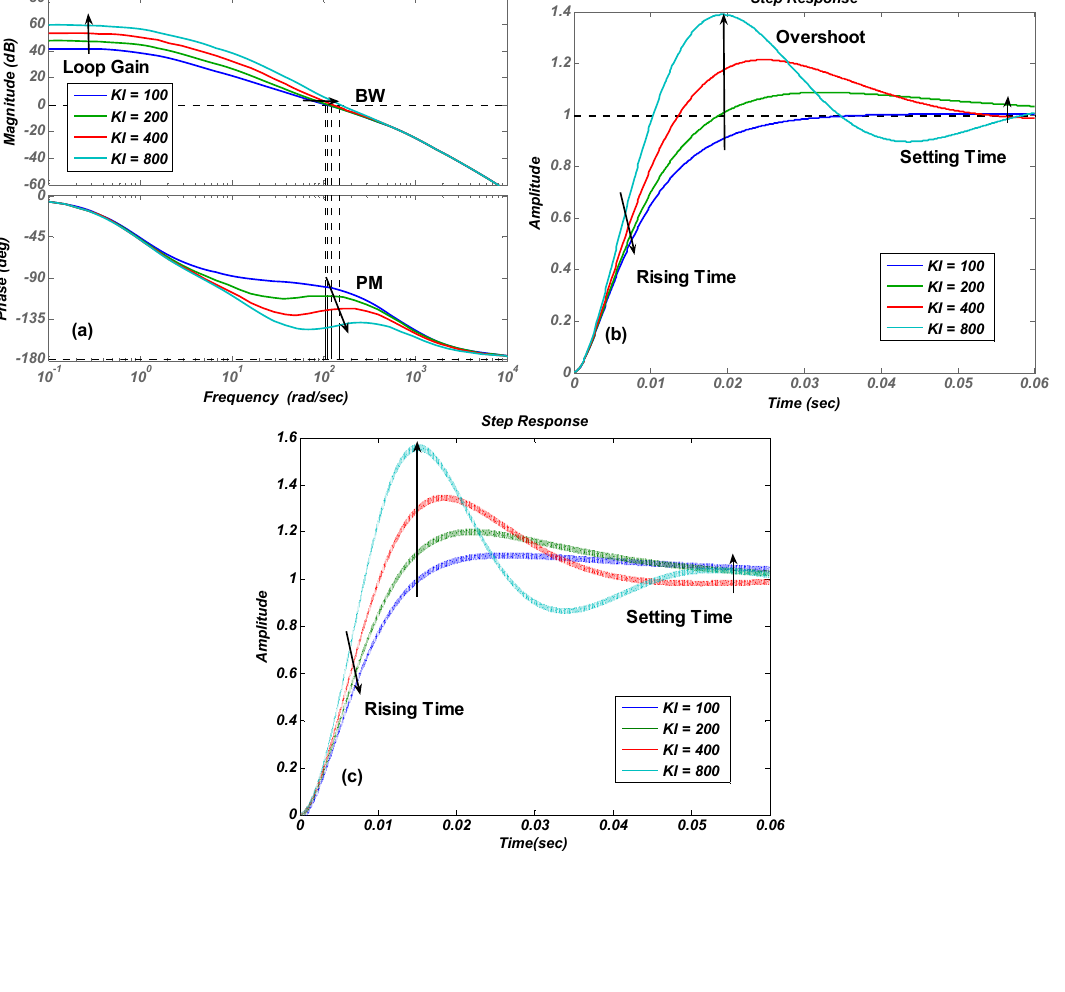
Figure 6. ( a ) Bode diagrams of the control loop ( b ) step responses of the linear model ( c ) and step responses of nonlinear model varying with the integral term K